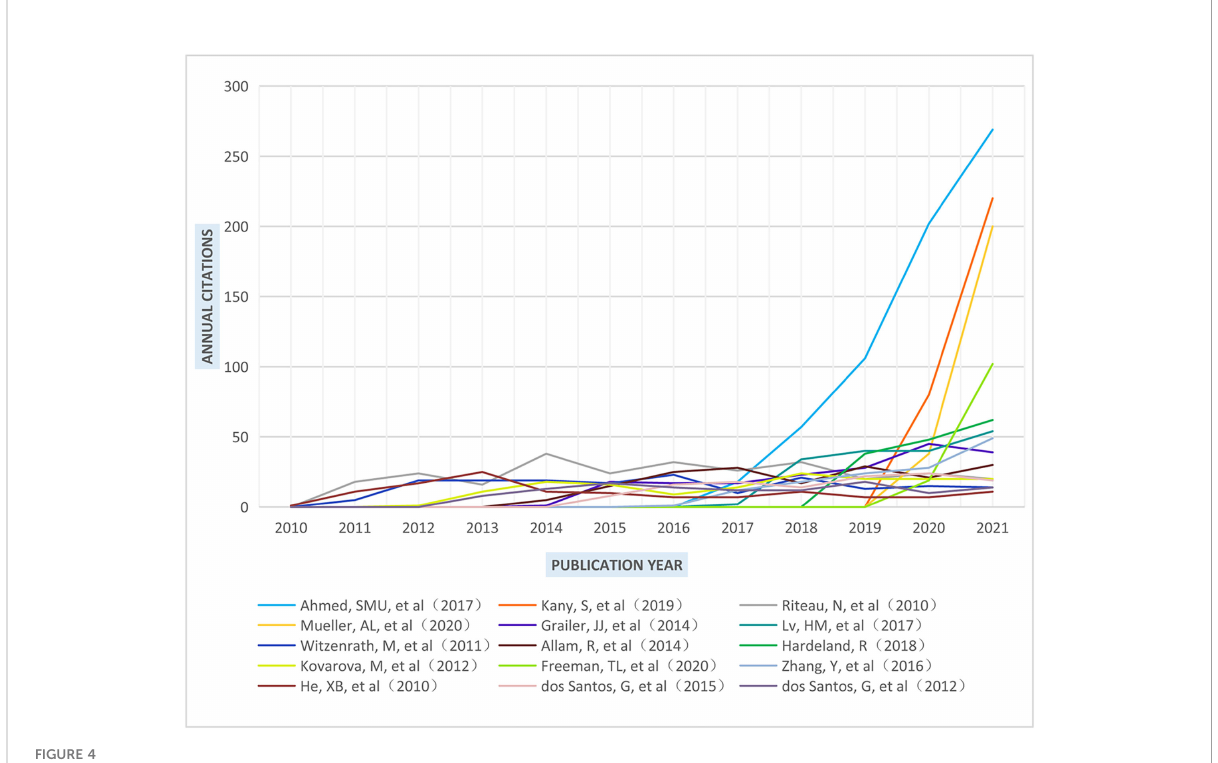
FIGURE 4 The annual number of citations of the top 15 highly cited